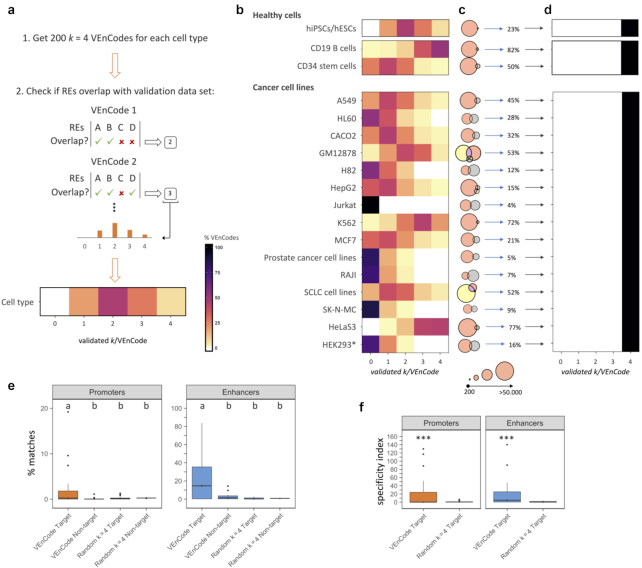
Cross-validation of CAGE-seq–determined VEnCodes. (a) Strategy for cross-validation of CAGE-seq–determined VEnCodes using external databases. (b) Heat maps depicting the distribution of cross-validated VEnCodes, for k = 4 enhancers, according to the number of validated k/VEnCode for each cell type. The databases used for cross-validation of each cell type and the full description of the cell types are provided in Supplementary Table S4. (c) Venn diagrams depicting the percentage of active enhancer calls determined in this study using the FANTOM5 database CAGE-seq data (gray circles; notice that they are sometimes too small to see in the figure) that overlap with the external cross-validation databases (peach and yellow). (d) Heat maps depicting the distribution of cross-validated VEnCodes, for k = 4 enhancers, according to the number of validated k/VEnCode for each cell type using exclusively CAGE-seq enhancers that are present in the external databases. *HEK293 cells originate from fetal kidney tissue, but they were placed in this group as they are derived from adenovirus-transformation and have a complex karyotype. (e) Box plots depict the percent matches between CAGE-seq–based VEnCodes and DNase-seq regions. Both VEnCodes and random combinations of k = 4 REs were retrieved from the CAGE-seq data set and their activity was assessed in the DNase-seq data set for both similar (target) and unrelated (non-target) cell types. Different letters represent conditions that are statistically significantly different (ANOVA followed by Tukey HSD; P < 0.01). (f) Specificity of CAGE-seq–derived combinations of REs (VEnCodes or random k = 4 combinations). Specificity was calculated as the percentage of target cell hits/average percentage of non-target cell hits. *** represents P< 0.001.